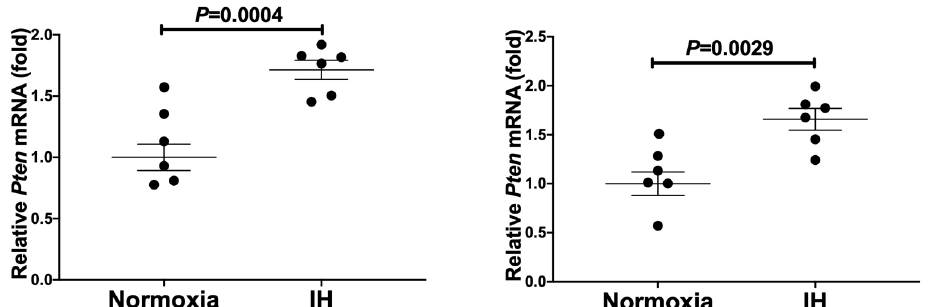
Figure 5. The mRNA levels of Pten in rat H9c2 ( left ) and mouse P19.CL6 ( right ) cardiomyocytes. Rat H9c2 and cardiomyocytic ‐ differentiated mouse P19.CL6 cells were treated with normoxia or IH for 24 h. The mRNA levels were measured by real ‐ time RT ‐ PCR and normalized by Rig/RpS15 as an internal standard. The mRNA level exposed to normoxia was set to 1.0. Data are expressed as mean ± SE of the samples ( n = 4 to 6). Statistical analyses were performed using Student’s t ‐ test. IH significantly increased the mRNA levels of Pten in rat H9c2 and mouse P19.CL6 cardiomyocytes. Correlation analysis in P19.CL6 cells revealed that the correlation coefficient(s) between Cd38 vs. Pten and Fkbp12.6 vs. Pten were − 0.221 and − 0.362, respectively, indicating that there are negative correlation(s).